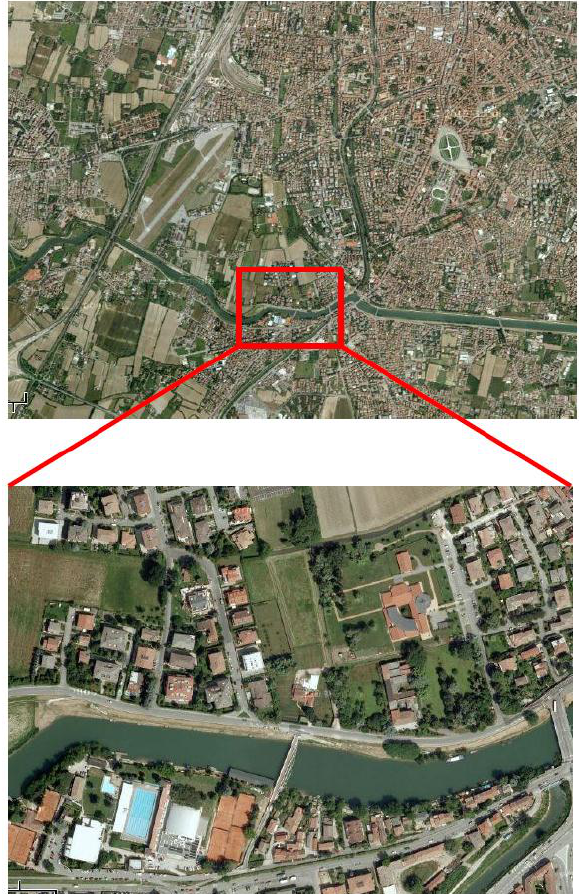
Figure 1. Study area, near the Bacchiglione River, Padova, Italy.